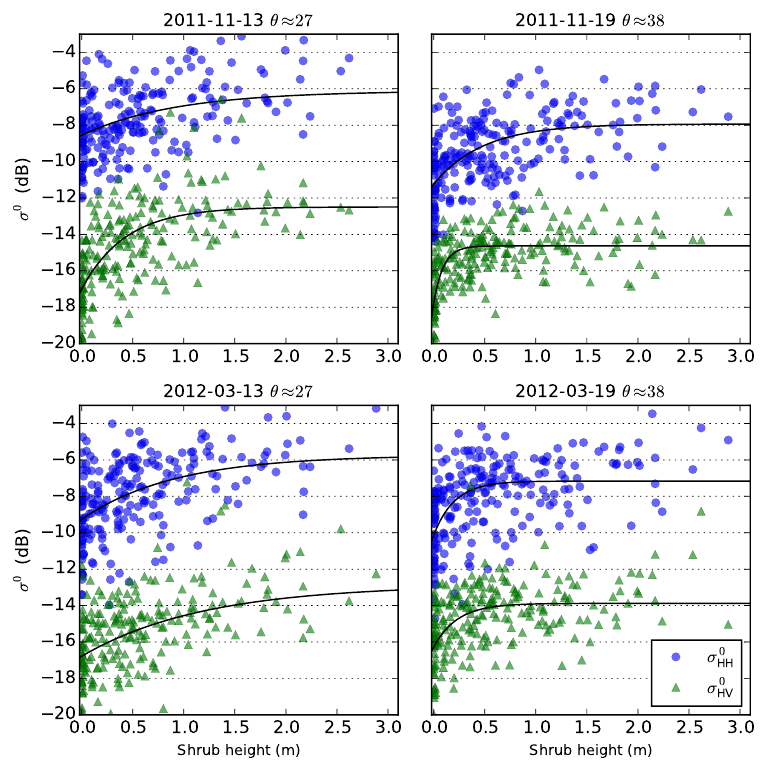
Figure 9. σ 0 as a function of vegetation height for TerraSAR-X acquisitions for November 2011 and March 2012 at θ ≈ 27 ◦ ( left ) and θ ≈ 38 ◦ ( right ) incidence angles. The blue circles represent HH polarization, and the green triangles represent HV polarization. The black lines are the best fit results for the